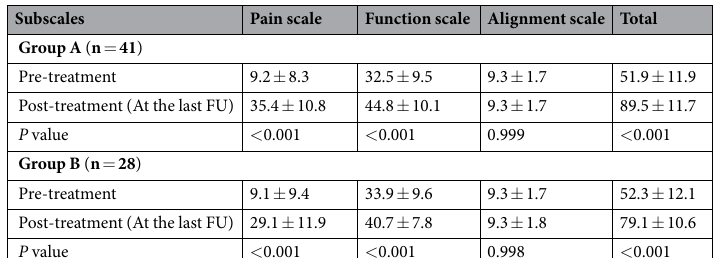
Subscales Pain scale Function scale Alignment scale Total Group A ( n = 41 ) Pre-treatment